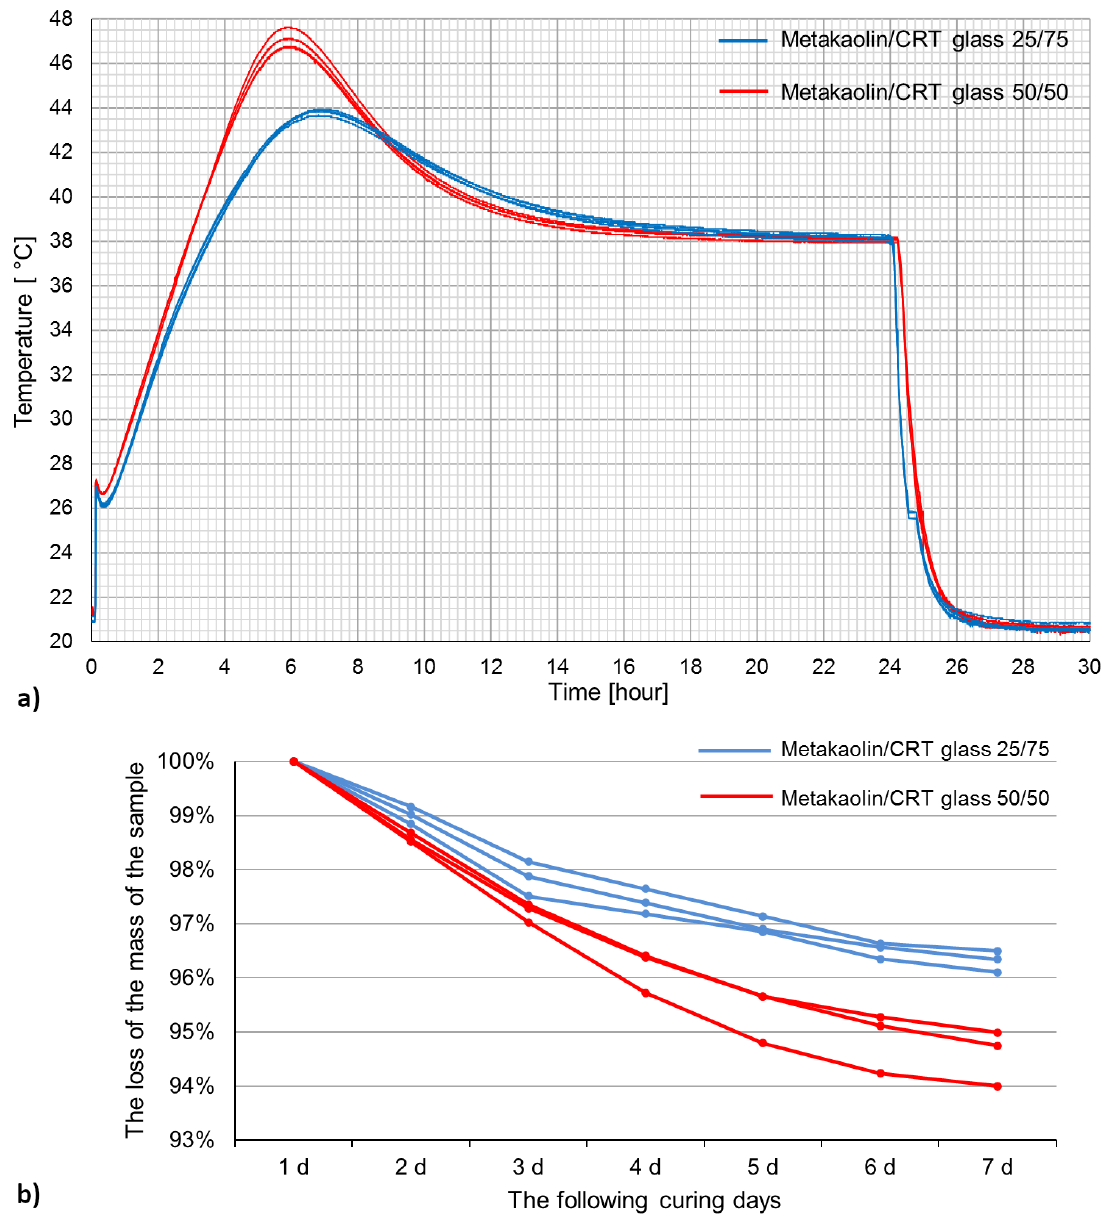
Figure 6. ( a ) The temperature changes in geopolymer samples during the first 30 h of curing; ( b ) the loss in mass of the samples containing 50% and 75% CRT glass during the following curing days.